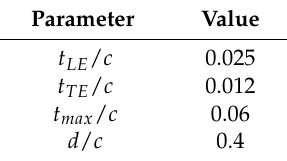
Table 2. Constant parameters for the thickness distribution of the nozzle blade profile [7].